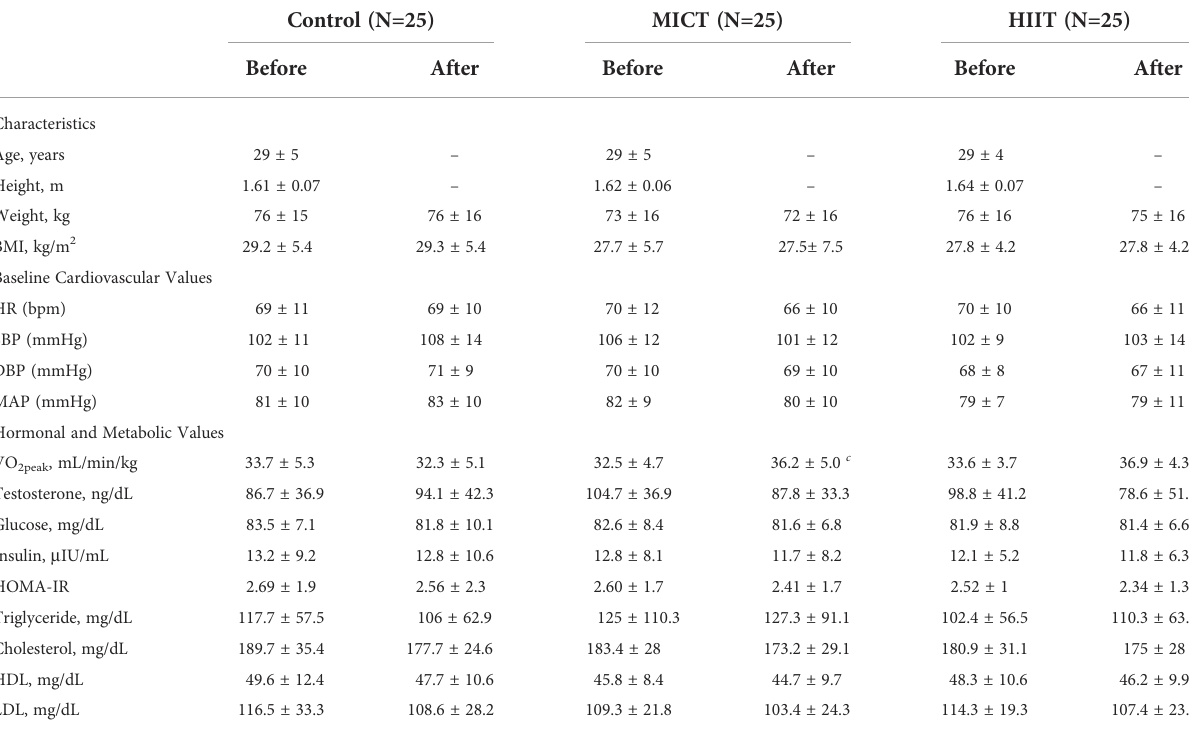
TABLE 1 The descriptive table of characteristics and hemodynamic, hormonal and metabolic parameters obtained before and after the 16-wk physical training (MICT and HIIT groups) or observation period without training (Control